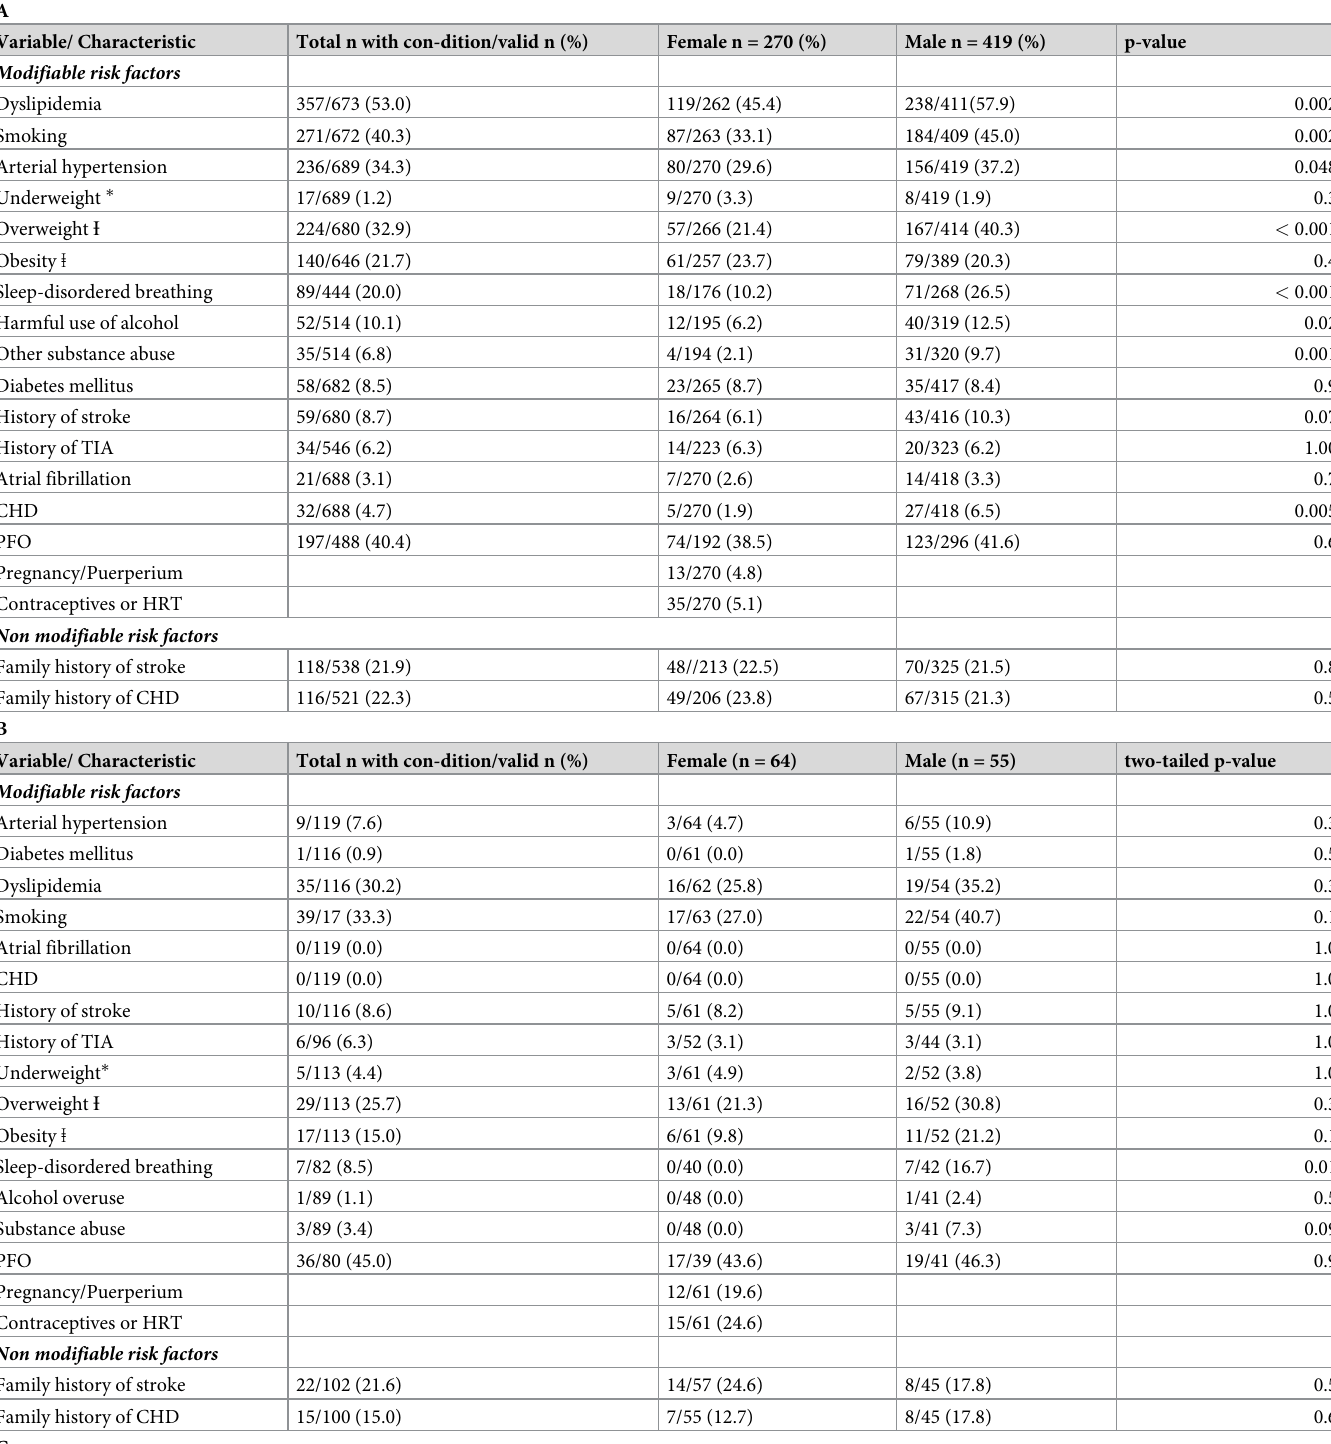
Table 1. A. Risk factors stratified according to sex. B. Risk factors stratified according to sex in very young AIS patients (16-35y). C. Risk factors stratified according to sex in young AIS patients